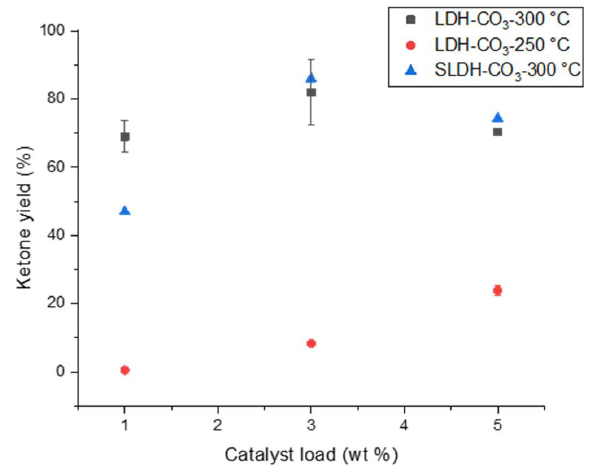
Figure 5. Yield of 12-tricosanone derived from the ketonic decarboxylation of lauric acid with the LDH-CO 3 and SLDH-CO 3.